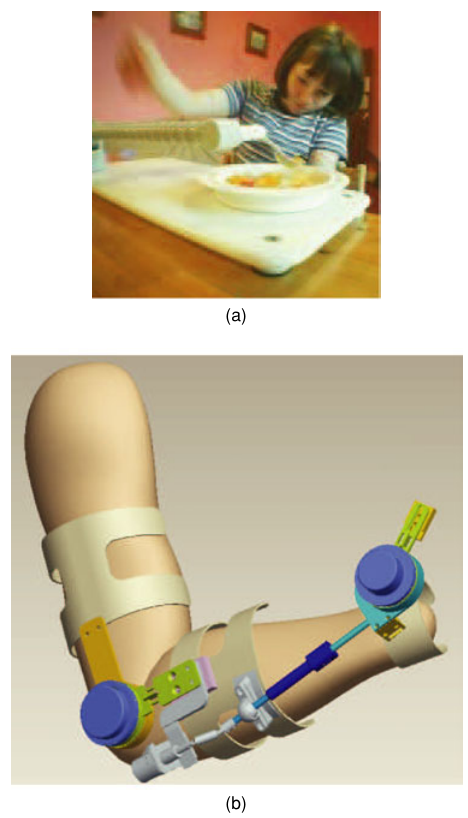
Figure 1 Typical examples of (a) non-ambulatory tremor suppression mechanism (Neater Eater) and (b) orthotic device for tremor reduction